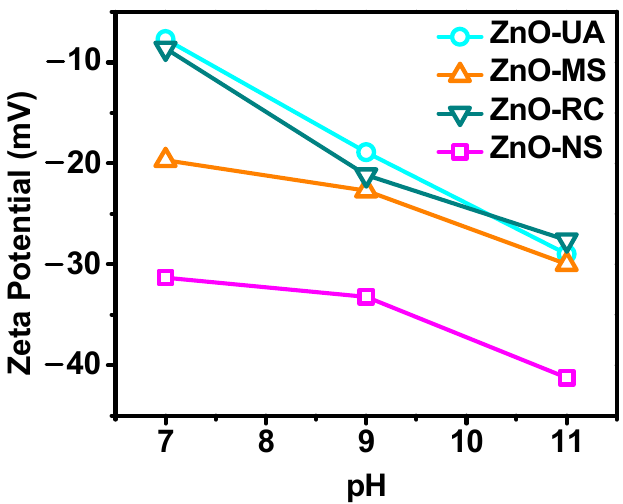
Figure 4. Zeta potential analysis of ZnO NPs at different pH values.